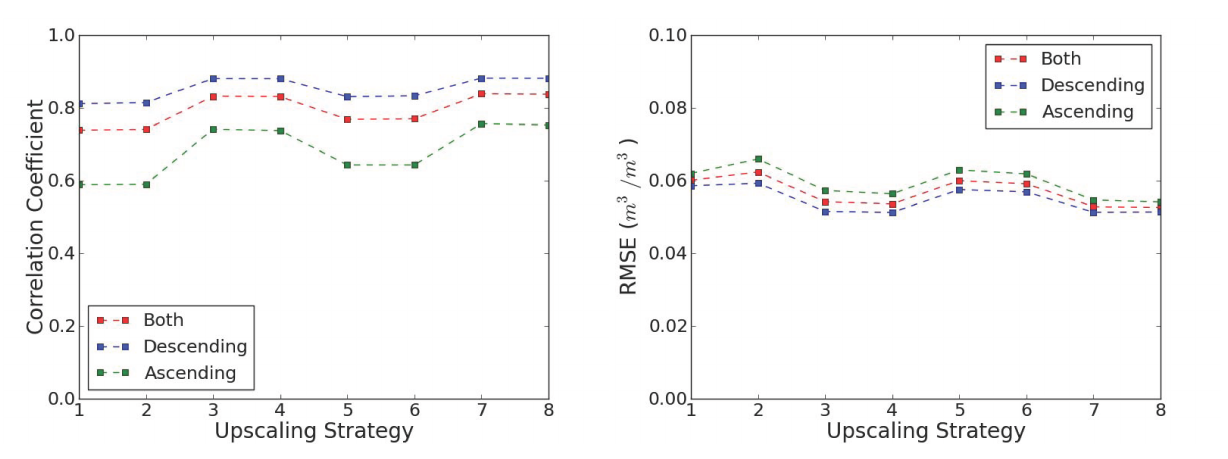
Figure 13. Comparison of the RADARSAT-2 soil moisture aggregated using eight strategies with the SMOS retrieved soil moisture in the ascending, descending and both the